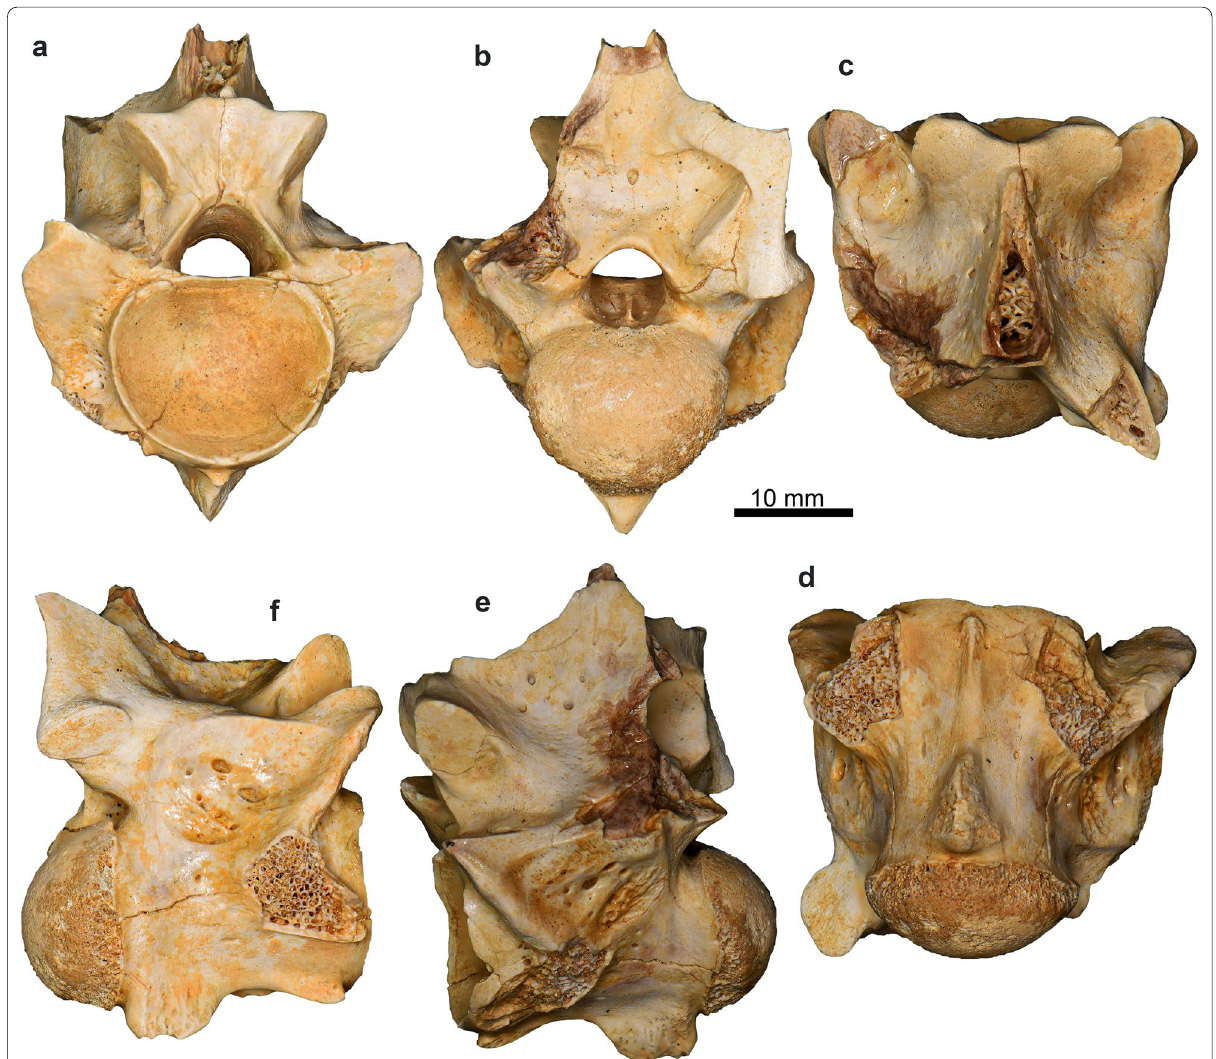
Fig. 6 Anterior to anterior mid-trunk vertebra UM KPO 26 in anterior ( a ), posterior ( b ), dorsal ( c ), ventral ( d ), left lateral ( e ), and right ventrolateral ( f )